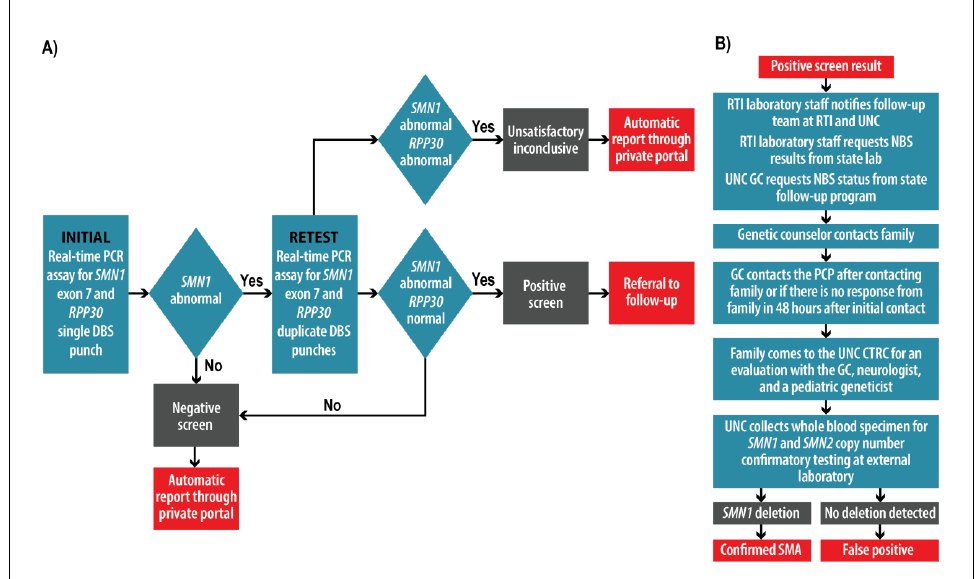
Figure 1. ( A ) Screening and ( B ) follow-up algorithms.